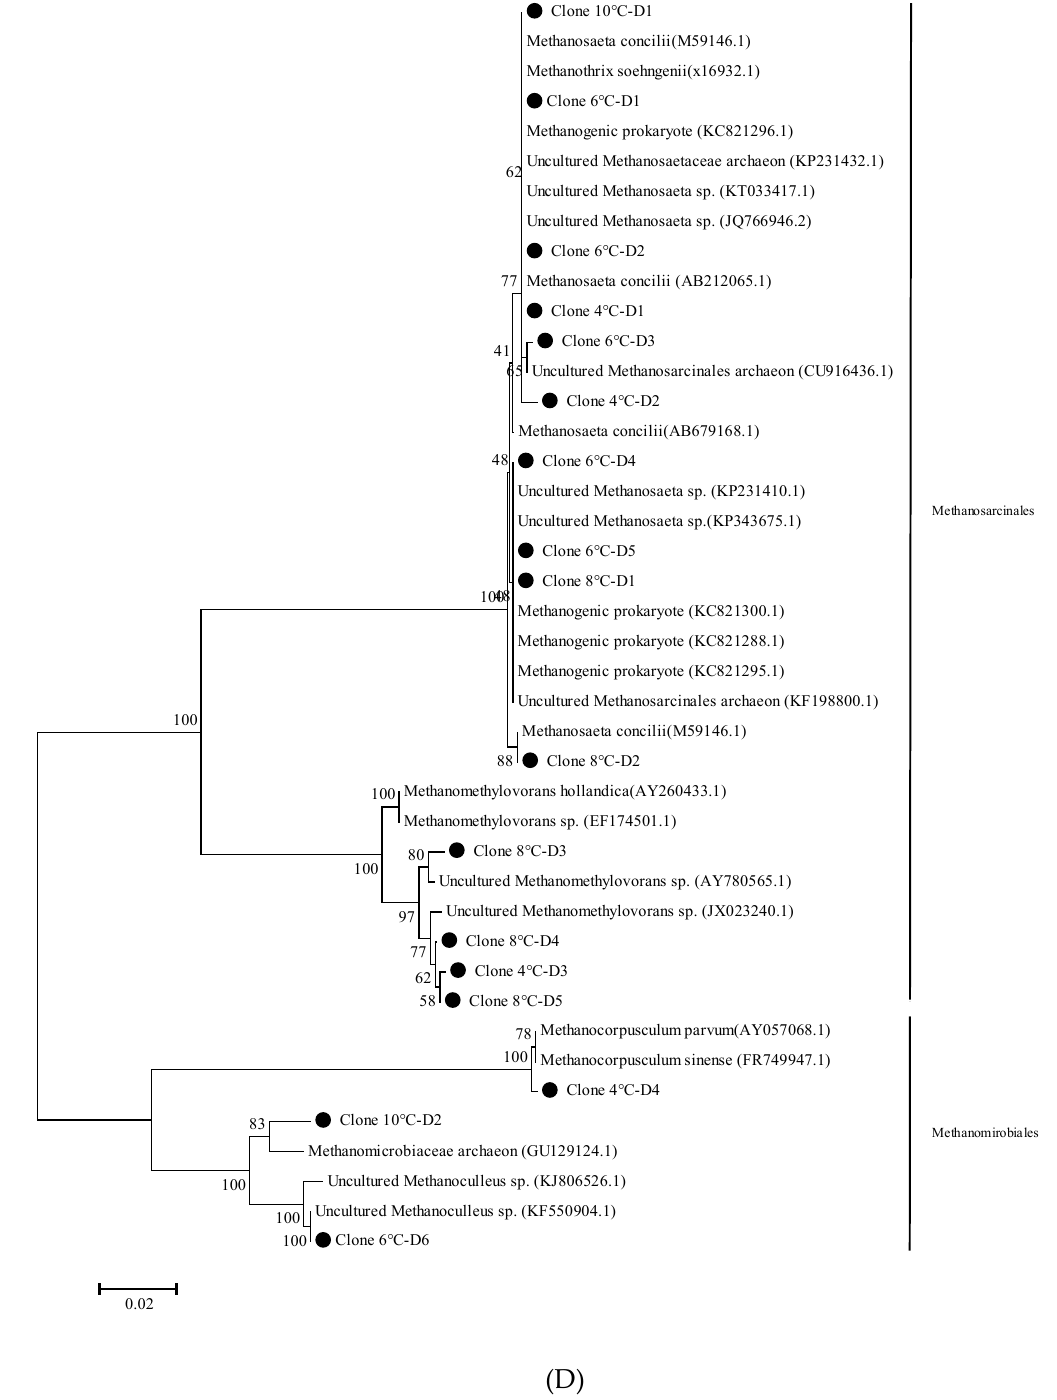
Figure 5. Phylogenetic tree showing the relationship among clones from seed sludge (S), adherent sludge (M), deposited sludge (D), and reference organisms. Solid circles (●) indicate clones from the sludge samples. Accession numbers are in parentheses for reference sequences from the GenBank database. The phylogenetic tree was constructed using the neighbor-joining method. Numbers shown at branch points are bootstrap values representing 1000 replications. The three bars signify 2% and 5% sequence divergence.